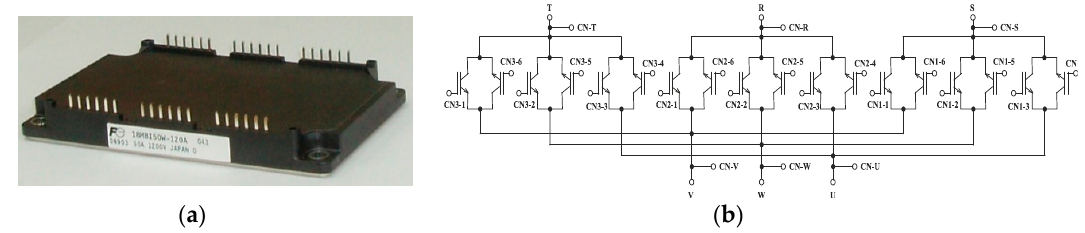
Figure 7. Matrix-connected RB-IGBTs module: ( a ) photograph; ( b ) topology structure.